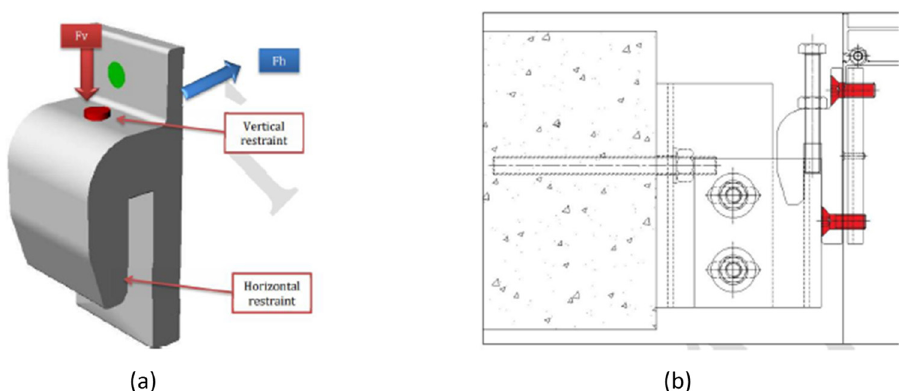
Figure 5. ( a ) Intermediate element for hanging panels and adjustment and leveling; ( b ) final detail of the joint between the slab and in plug and play modular system.